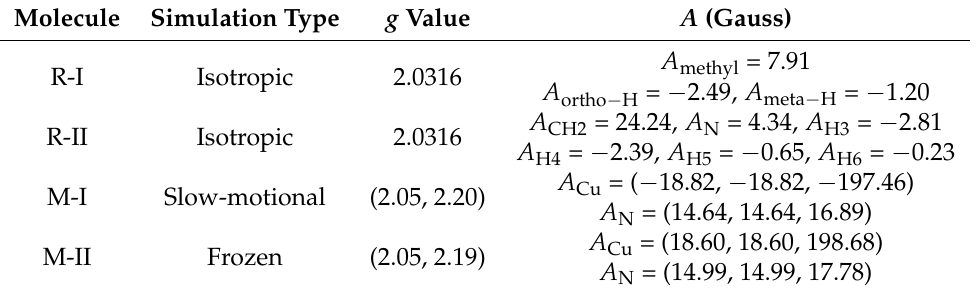
Table 1. Simulation parameters for M-I, M-II, R-I, and